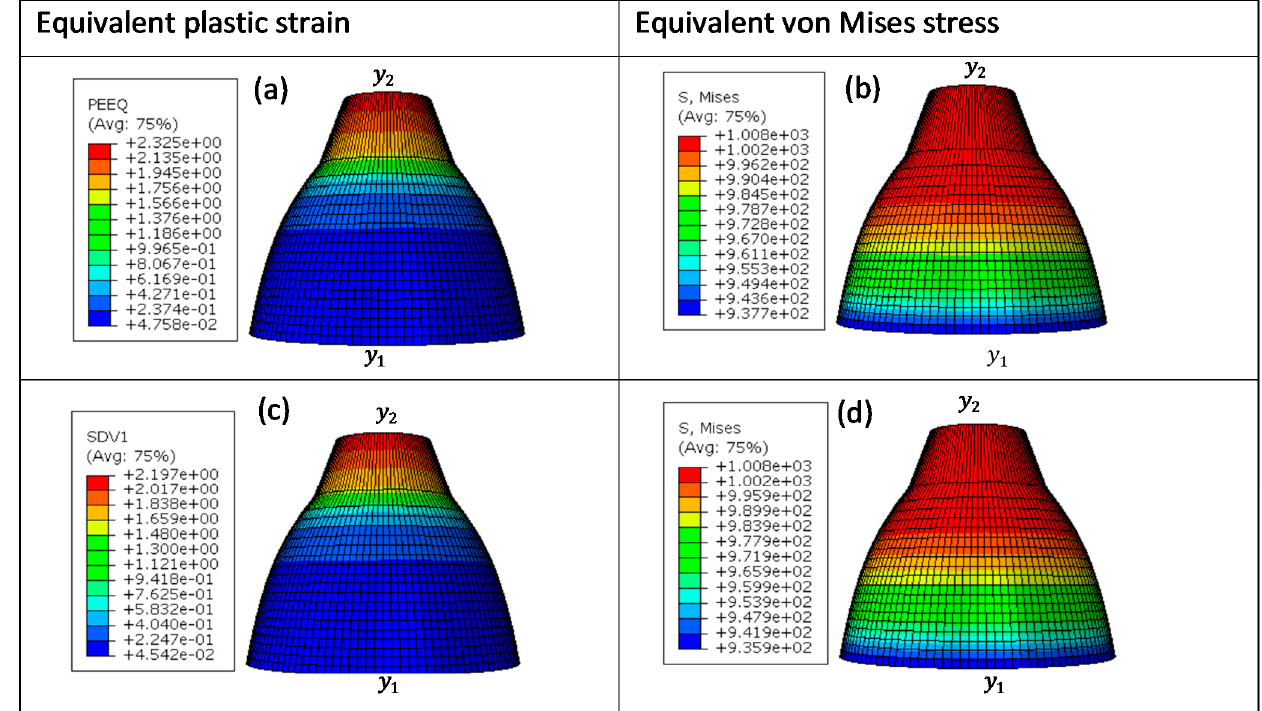
Figure 15. Numerical estimation of ( a , c ) equivalent plastic strain and ( b , d ) equivalent von Mises stress distribution in ( a , b ) VUHARD and ( c , d ) VUMAT subroutines developed here, using 0.5 mm mesh size, at a test velocity of 4 m/s and temperature of 298 K.